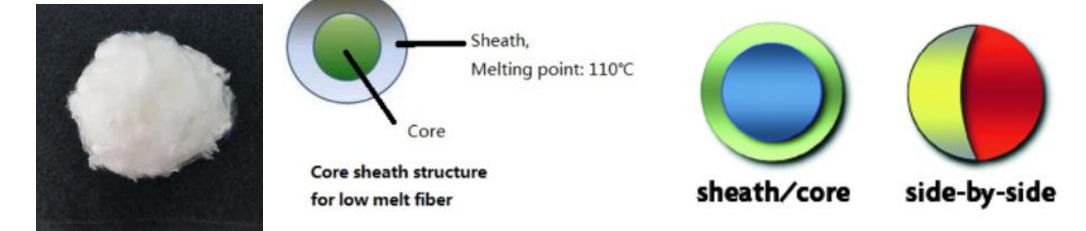
Figure 8. Polyester staple low melt fibers and their core sheath structure.